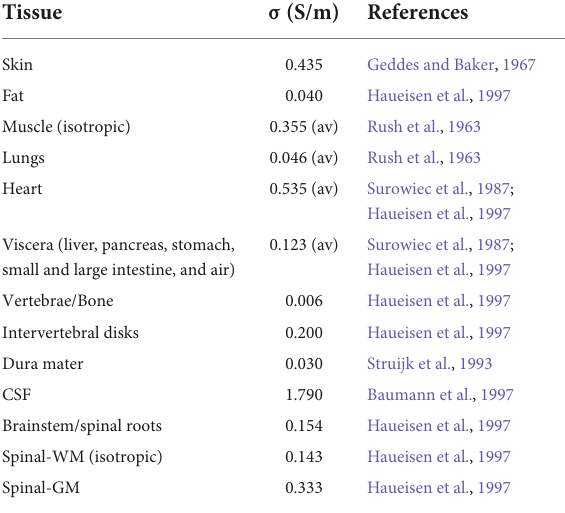
TABLE 1 Electric conductivities of tissues considered in the human